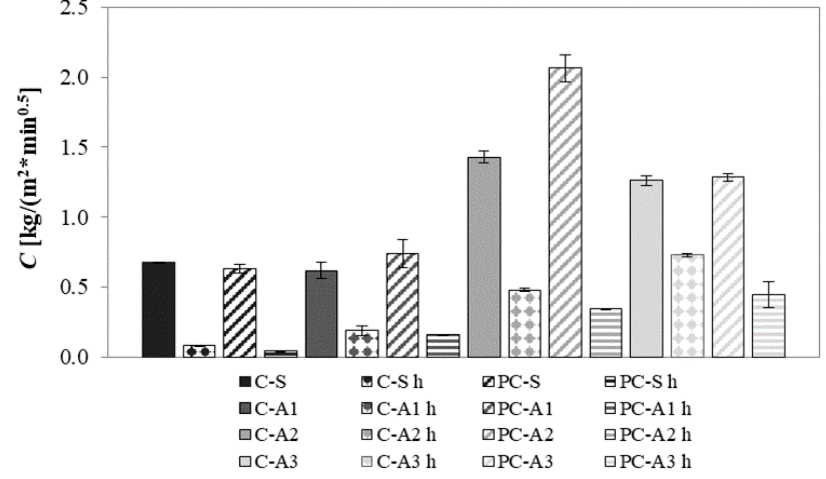
Figure 7. Capillary water absorption coefficient of mortars.